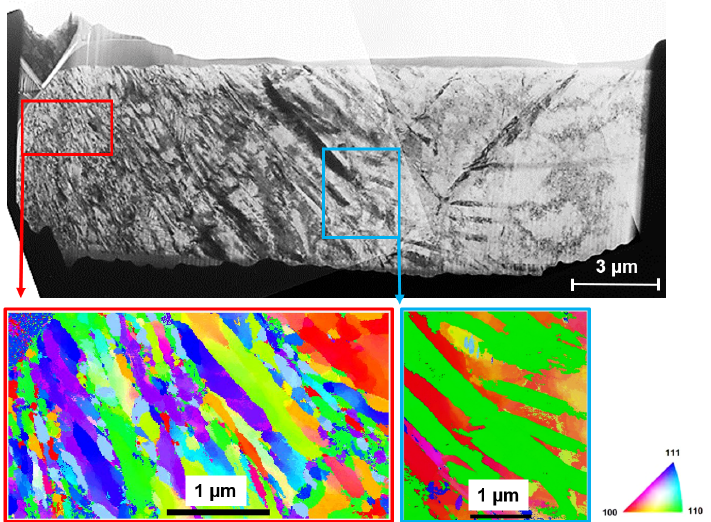
Figure 6. TEM bright-field image of as-machined FT1 from annulus subsurface ( left ) to the core ( right ). The color-coded maps indicating the local crystallographic orientation of the surface normal reveal the transition of microstructure from the immediate-subsurface to the alloy